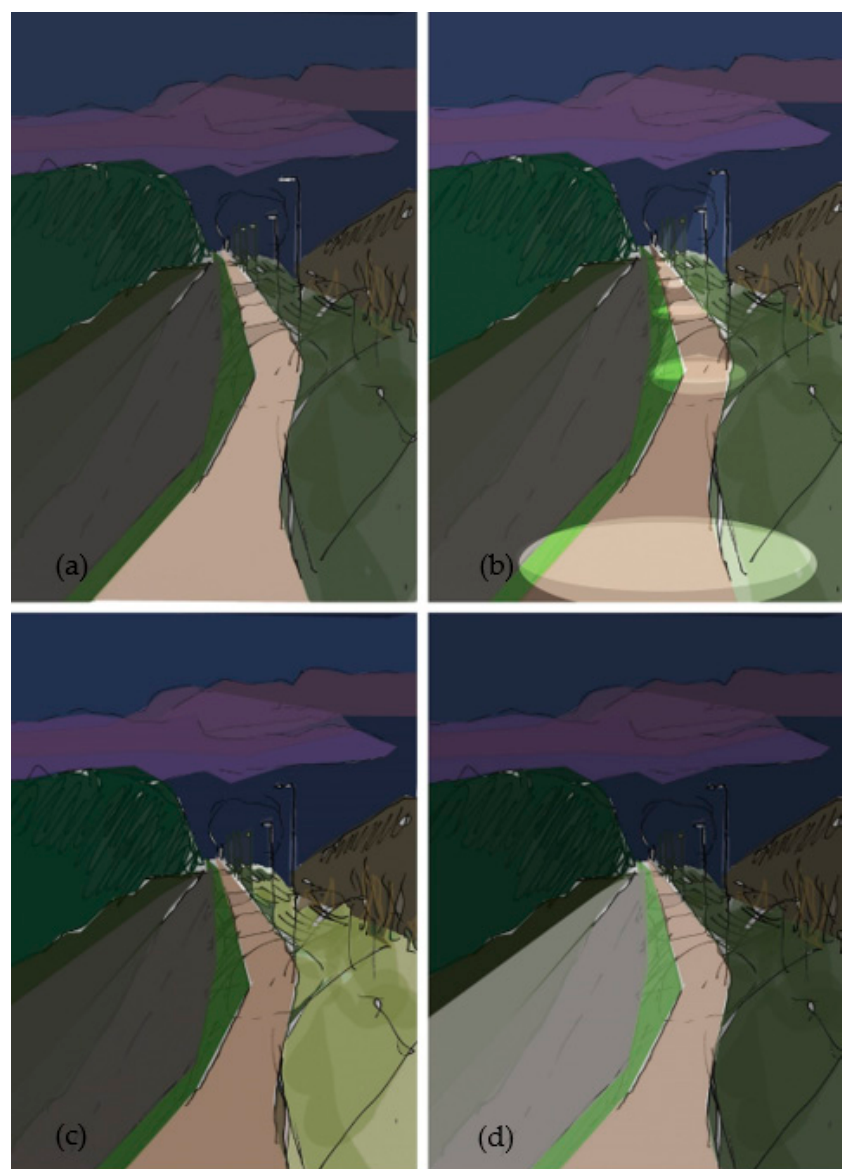
Figure A2. Reflective sketches from Lockebo, showing possible implications from lighting variations (from left to right, top to bottom): ( a ) Just the walkway is lit, not the car road. It is a primarily uniform light; the road seems prolonged. It is far to walk. The road looks repetitive. A pedestrian would be exposed. This is the light situation of today. ( b ) Less uniform light creates rhythm that reduces the repetitive expression. The light zones give visual guidance as milestones. ( c ) Both the walkway and the slope next to it are reached by light. In a way, this contributes to creating a vertical wall in the landscape. Therefore, the walkway receives less attention, and the sense of exposure can be reduced. ( d ) Both the car lane and the walkways are lit. The horizontal surfaces appear, while everything else disappears in darkness. The urban space can be experienced as wide, large and empty.